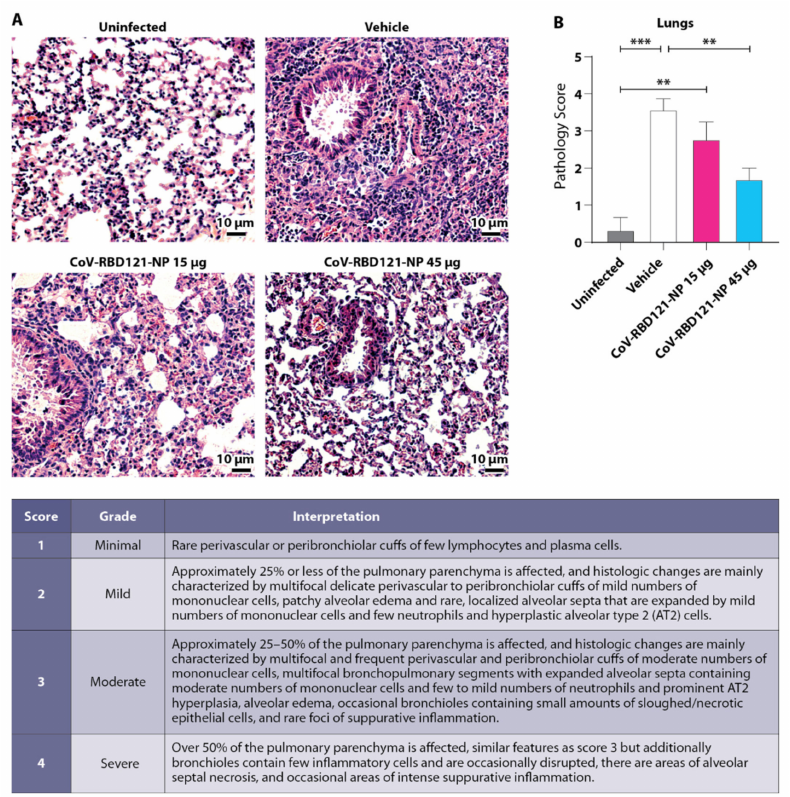
Figure 5. Lung pathology in lungs of mice vaccinated with CoV-RBD121-NP and challenged with SARS-CoV-2. ( A ) Lung tissue was collected upon death or at the end of the experiment from mice in each group, as well as from age- and sex-matched mice that were not challenged with SARS-CoV-2 (uninfected, n = 3). Representative tissue sections stained with hematoxylin and eosin are shown. Scale bar = 10 µ m. ( B ) Pathology was quantified using the scoring criteria (chart) from 3 to 10 images for each group. Statistical differences were determined by one-way ANOVA with Tukey’s post hoc test, ** p < 0.01, *** p <